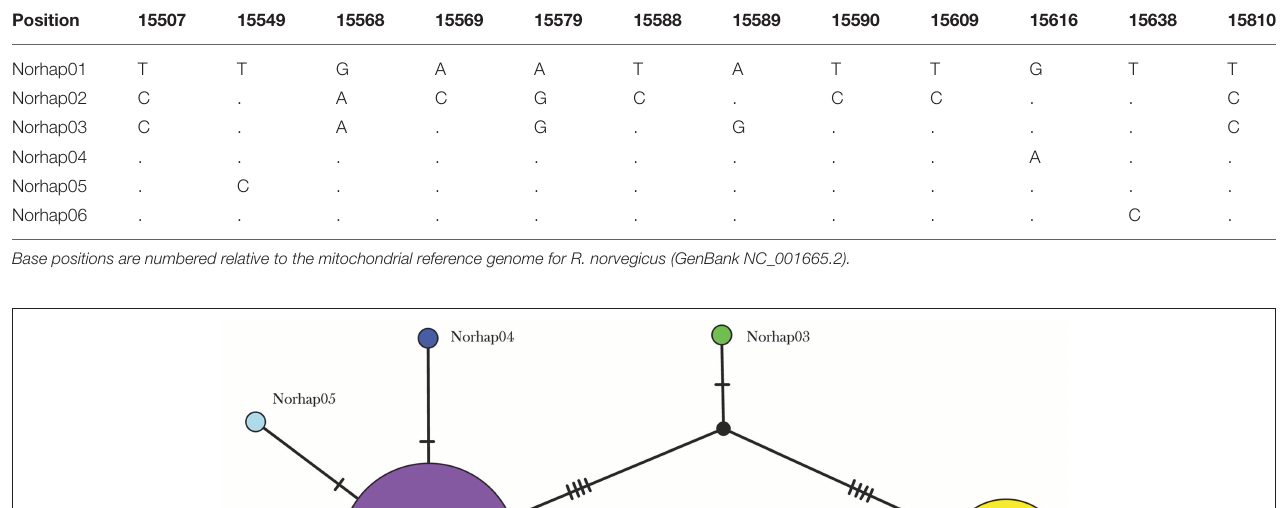
TABLE 2 | Differences in the base composition of R. norvegicus haplotypes from across the New Zealand archipelago. Position